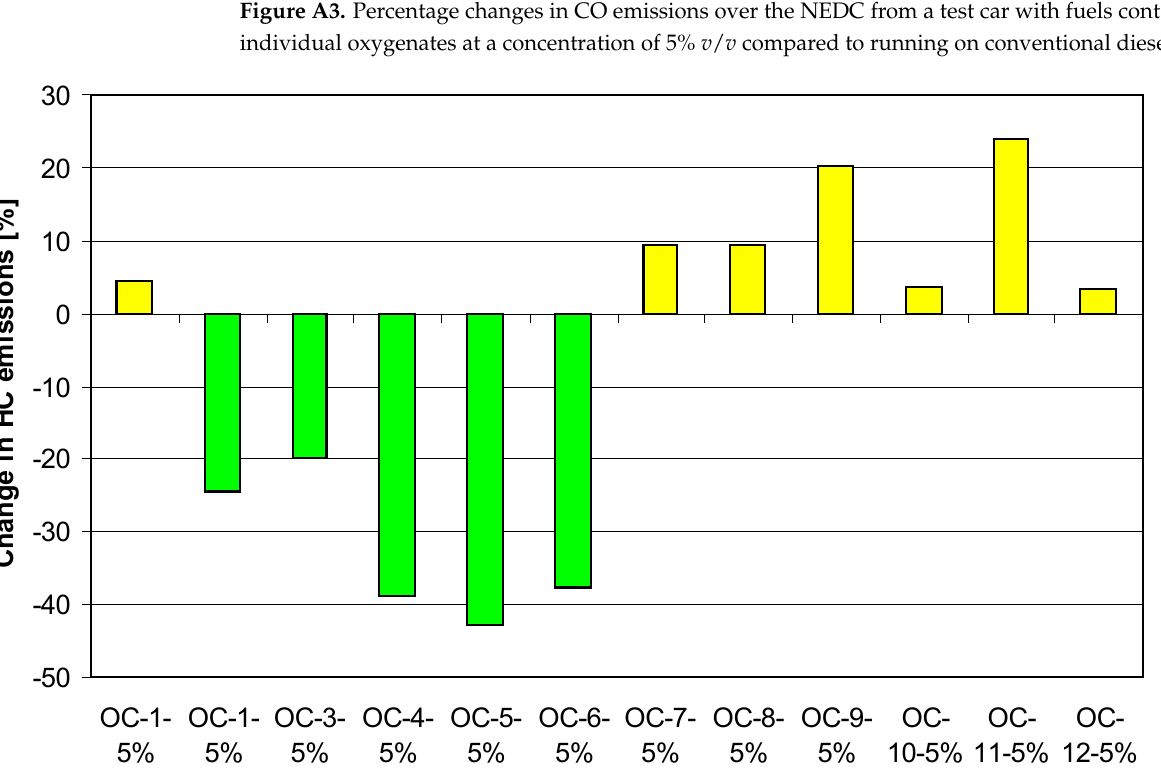
Figure A4. Percentage changes in HC emissions over the NEDC from a test car with fuels containing individual oxygenates at a concentration of 5% v / v compared to running on conventional diesel fuel.